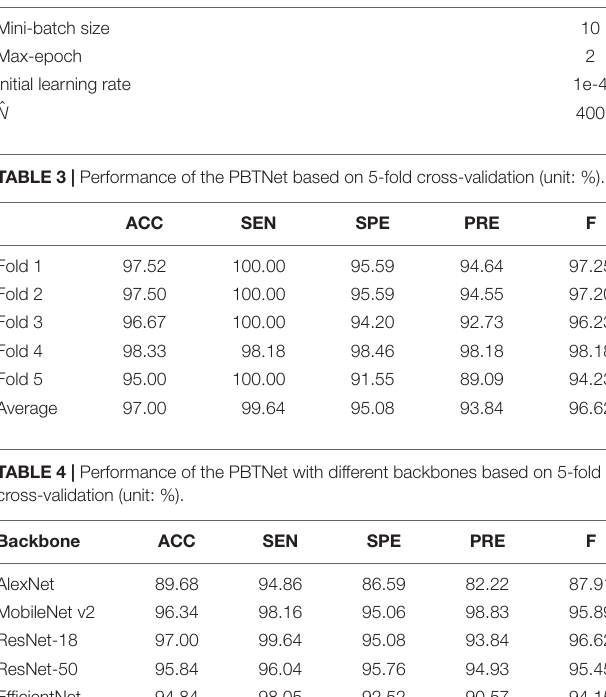
layer to the output layer more and more accurately. As the linear unit (ReLU):